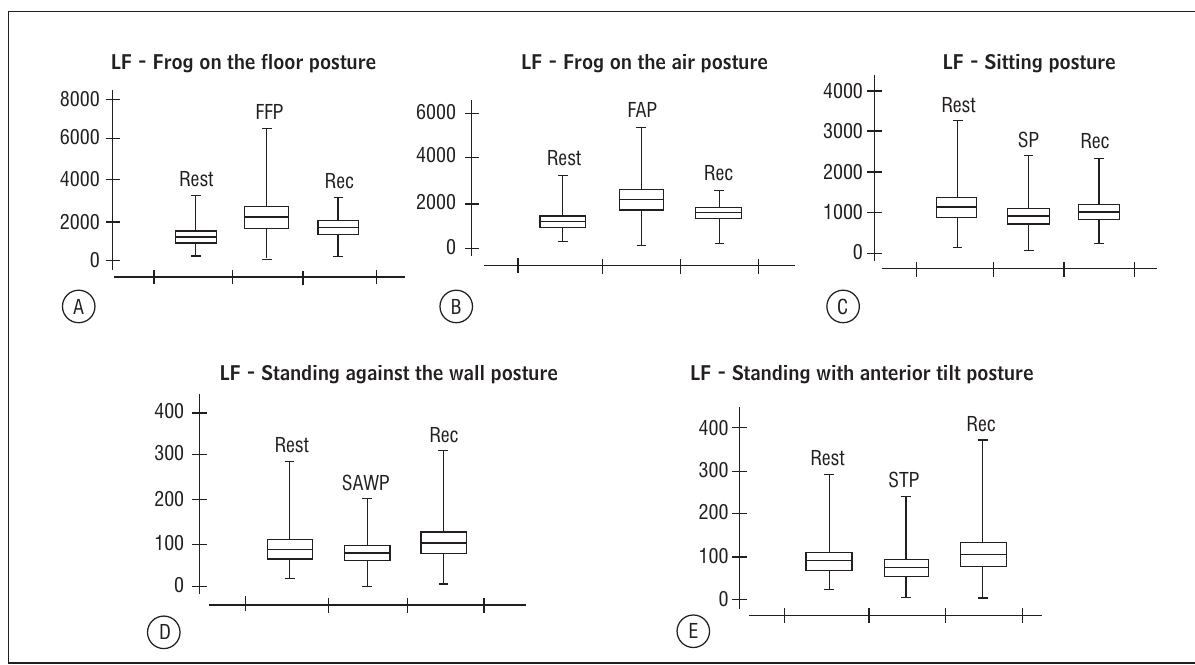
Figure 1 - Boxplot of the mean plus one standard error of the LF values (sympathetic area) during the rest (Rest), the pos- tures: A) frog on the floor (FFP), B) frog in the air (FAP), C) sitting (SP), D) standing against the wall (SAWP), and E) standing with anterior tilt (SATP) and during the recovery (Rec) Source: Research data.